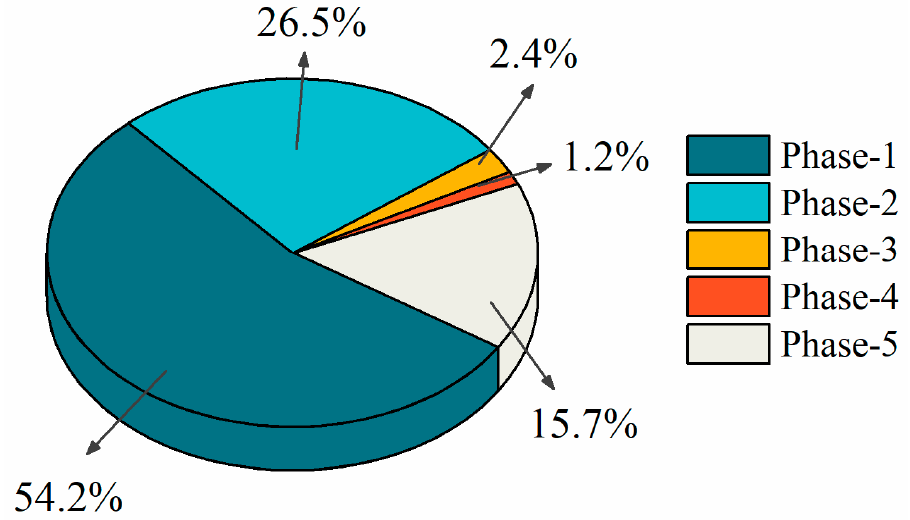
Figure 9. Displacement distribution in each process of crash test.